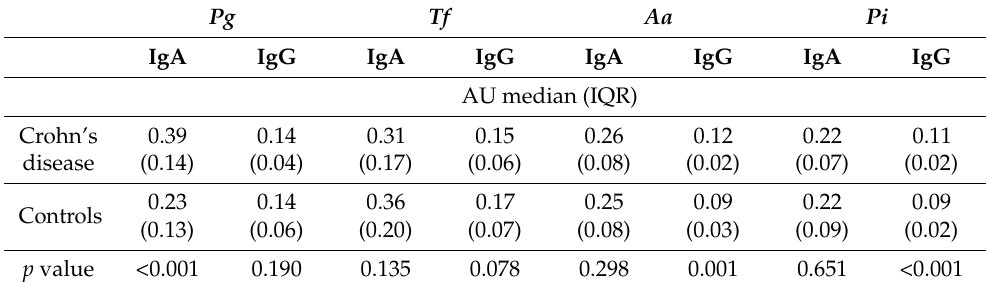
Linear regression models indicated independent associations of elevated salivary P.